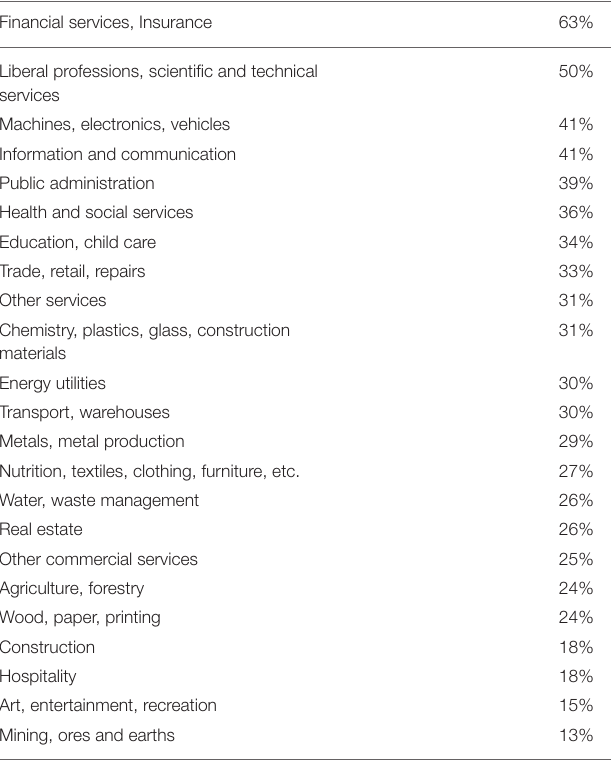
TABLE 3 | Sectors of the economy with the respective shares of companies that expect increasing digitalization over the next 5